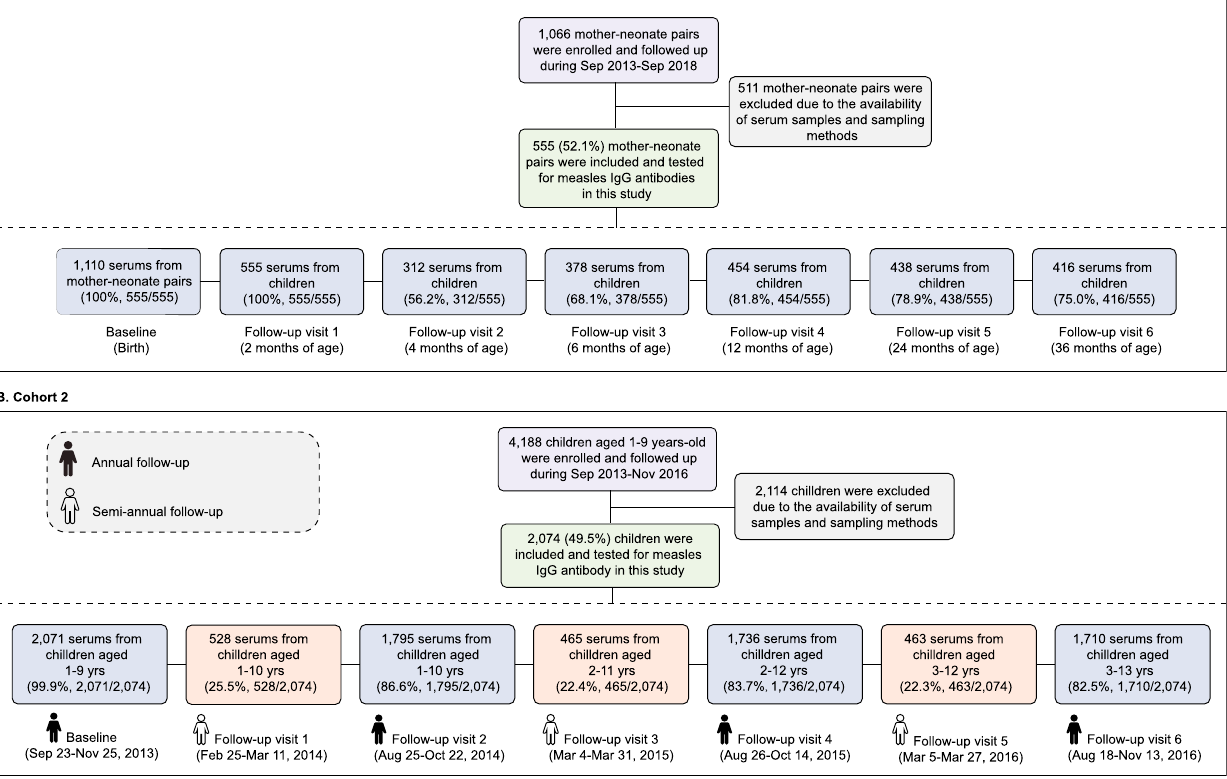
Fig.1|Overviewofstudyparticipants.A Recruitmentandfollow-upofparticipantsinthecohortofmother – neonatepairsand B inthecohortofchildrenaged1 –